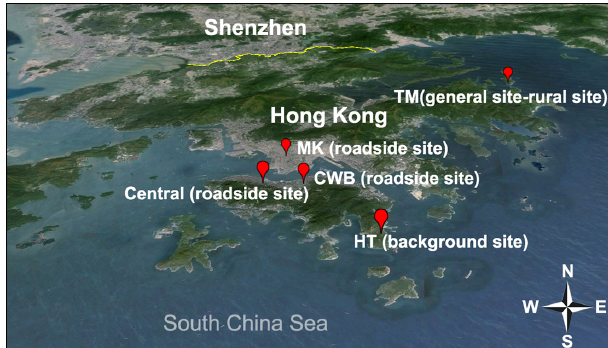
Figure 1. Geographical location of the sampling sites. The yellow line represents the border between Hong Kong and mainland